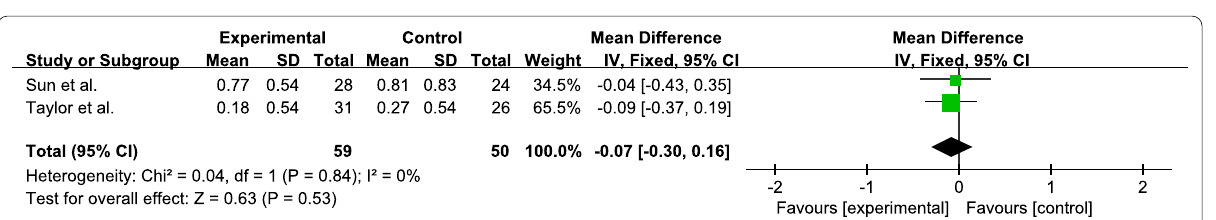
Fig. 3 Forest plot of the VAS by day 10 between the experimental group and the control group